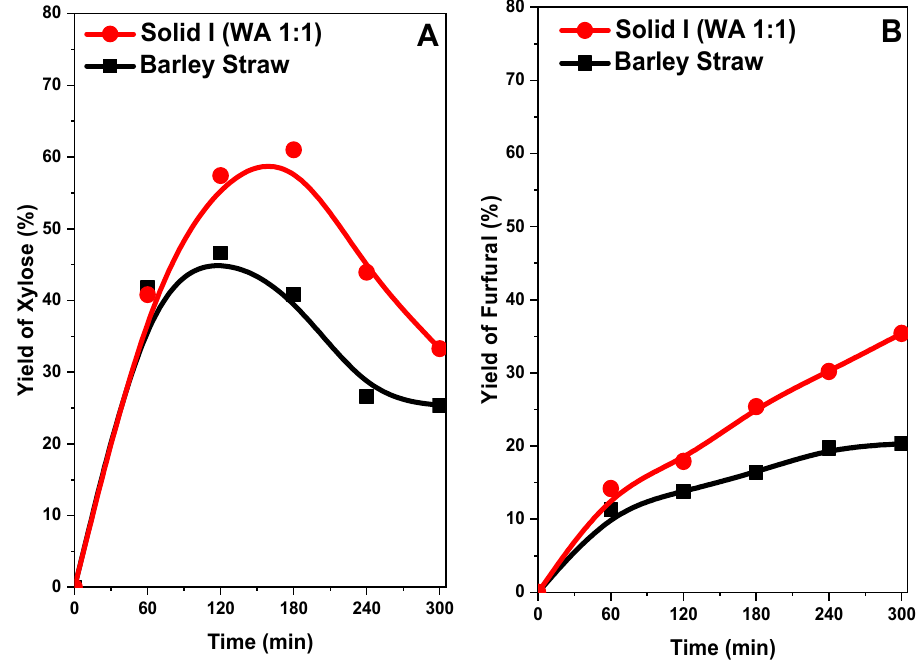
Figure 13. Yields of xylose ( A ) and furfural ( B ) of barley straw treated and not treated with [EMIMAcO] The furfural yield profiles indicate that the yield increases with reaction time, reaching, 36% with Solid I and 20% with untreated barley straw at 5 h. The Solid I sample had a higher concentration because the xylose concentration was higher than in the untreated sample.